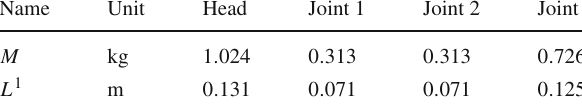
The notation L means the length of each segment